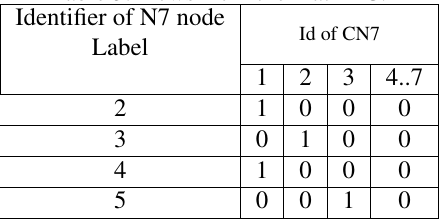
Table 5. Rows from the matrix C. Identifier of N7 node